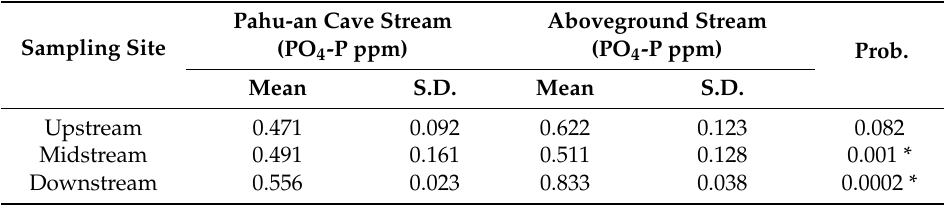
Table 3. Phosphate content (sediments).